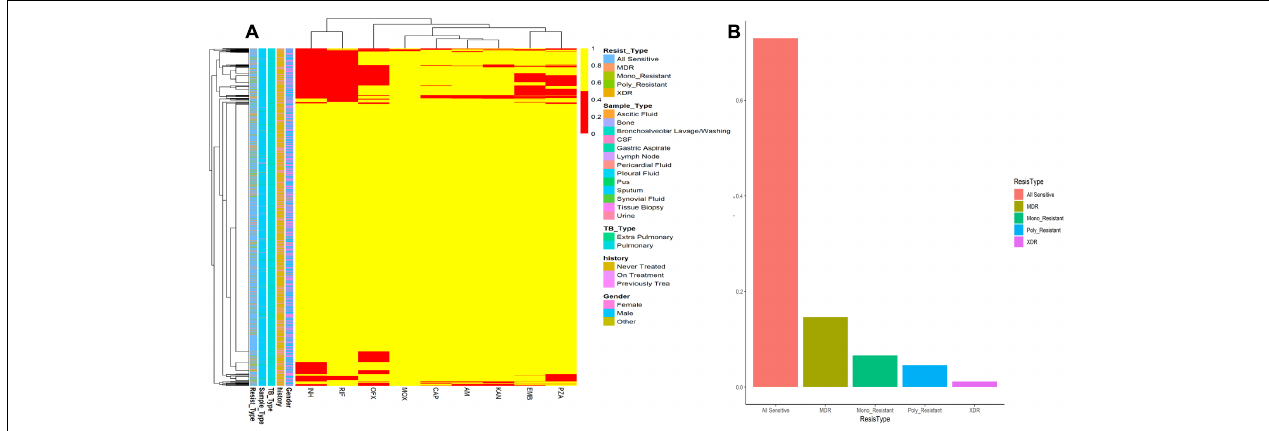
FIGURE 4 | (A) Drug resistance among MTB isolates from Khyber Pakhtunkhwa. Frequency of all sensitive, MDR, Mono_Resistant, Poly resistant, and XDR are color coded. (B) Patients data and drug resistance pattern. Drug resistance is shown by red color while drug sensitive isolates are colored yellow. Resistance type (Resist_Type), Sample_Type, TB_Type, previous TB History of patients, and Gender are color